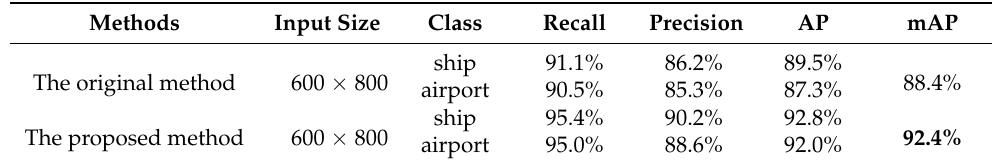
Figure 11. Effect of scale expansion layer. ( a ) is the initial image. ( b ) is the image with the truth box. ( c ) is the detection image without the scale expansion layer method. ( d ) is the detection image using the scale expansion layer method. As shown in the figure, ( e , f ) are simple scenes, and ( g , h ) are complex scenes. Table 3. Feasibility of scale expansion